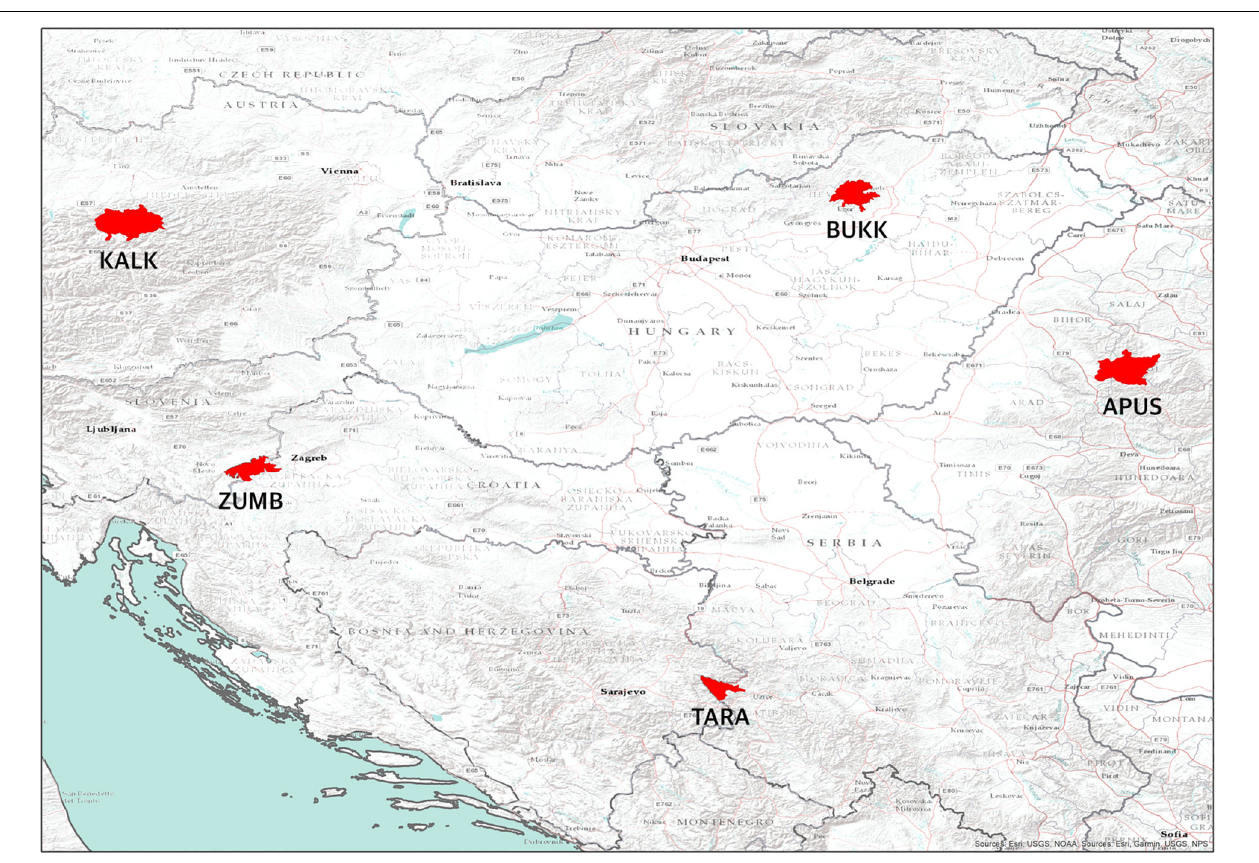
FIGURE 1 | Central-Eastern Europe, our study sites are highlighted with